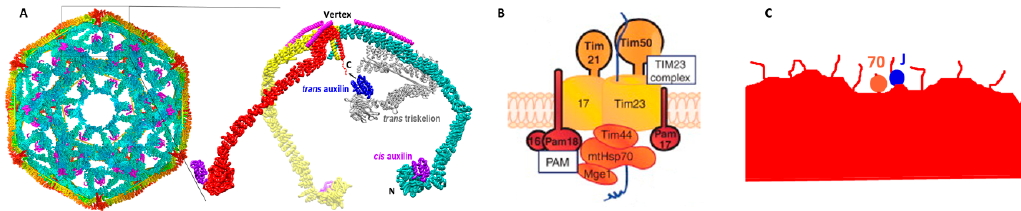
Figure 4. Mechanisms of J cochaperone loading of Hsp70s into constrained spaces. ( A ) Loading Hsp70 onto clathrin cages. Structure of a clathrin:auxilin coat with auxilin in magenta, the interior of the coat in cyan and the exterior in yellow and orange, and with the vertices that mark the C-terminal region of clathrin in red. The expanded section shows a triskelion from this coat with the 3 clathrin heavy chains in cyan, yellow, and red, and the clathrin light chains in magenta (pdb 1XI5 [17]). Part of a neighboring triskelion is shown in grey. Auxilin J domains (purple and blue) bind the globular N-terminal domain of clathrin (“N”) and load Hsp70 onto the flexible C-terminal tails (“C”) located in the constrained space under the vertex of a clathrin triskelion. Loading of Hsp70 onto isolated triskelia is ine ffi cient, possibly because of the distance between the clathrin N- and C-termini. But in a clathrin coat, triskelia are positioned with their N-terminal domains close to the C-termini of their neighbors, allowing for e ffi cient auxilin mediated loading in trans. ( B ) Loading of mtHsp70 onto translocating proteins. Architecture of the mitochondrial translocation pore. Tim44 and Pam18 recruit Hsp70 to